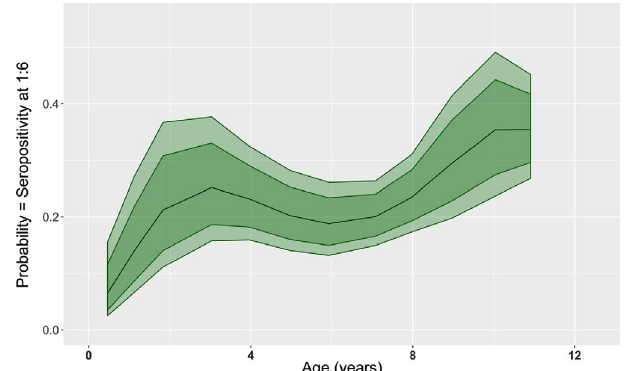
Figure 6. Prediction by the fi nal model of the age-related seroprevalence (cut-off titer of 6), with the 95% con fi dence interval represented by the light green colour and the 80% con fi dence interval by the dark green